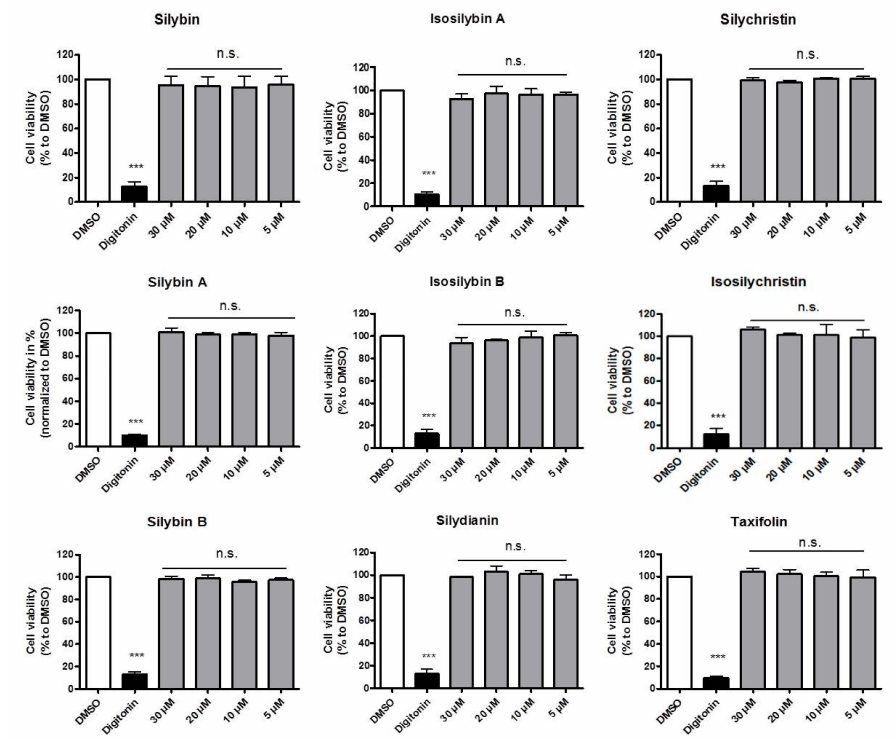
Figure 2. Effect of the investigated compounds on THP-1 cell viability. Resazurin conversion assay was used for the analysis of THP-1 viability. THP-1 cells were first differentiated into macrophages with 200 nM PMA for 72 h. Then, cells were treated with solvent vehicle control (DMSO), 50 µ g/mL digitonin and the indicated compounds from 5 to 30 µ M for 24 h. After the treatment, THP-1 macrophages were washed and incubated with 10 µ g/mL resazurin for another 4 h. Fluorescence of converted resorufin was measured and the increased fluorescent signal was quantified as cell viability. Experiments were performed three times in triplicate. All values are mean ˘ SD ( n = 3) compared to the solvent vehicle control (DMSO), n.s.: not significant, *** p < 0.001